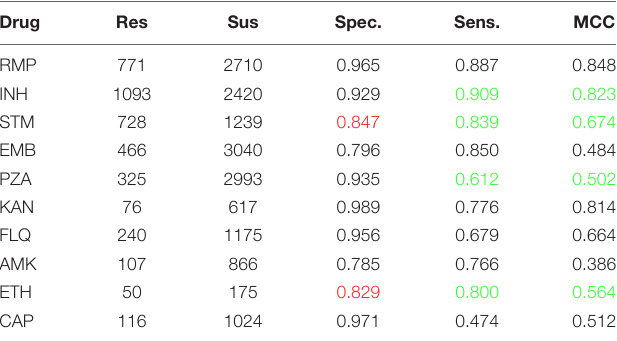
TABLE 4 | PointFinder predicted resistance compared with phenotypic drug susceptibility testing on the ReSeq data set when considering premature stop codons in katG, pncA, ethA, and gidB as resistance